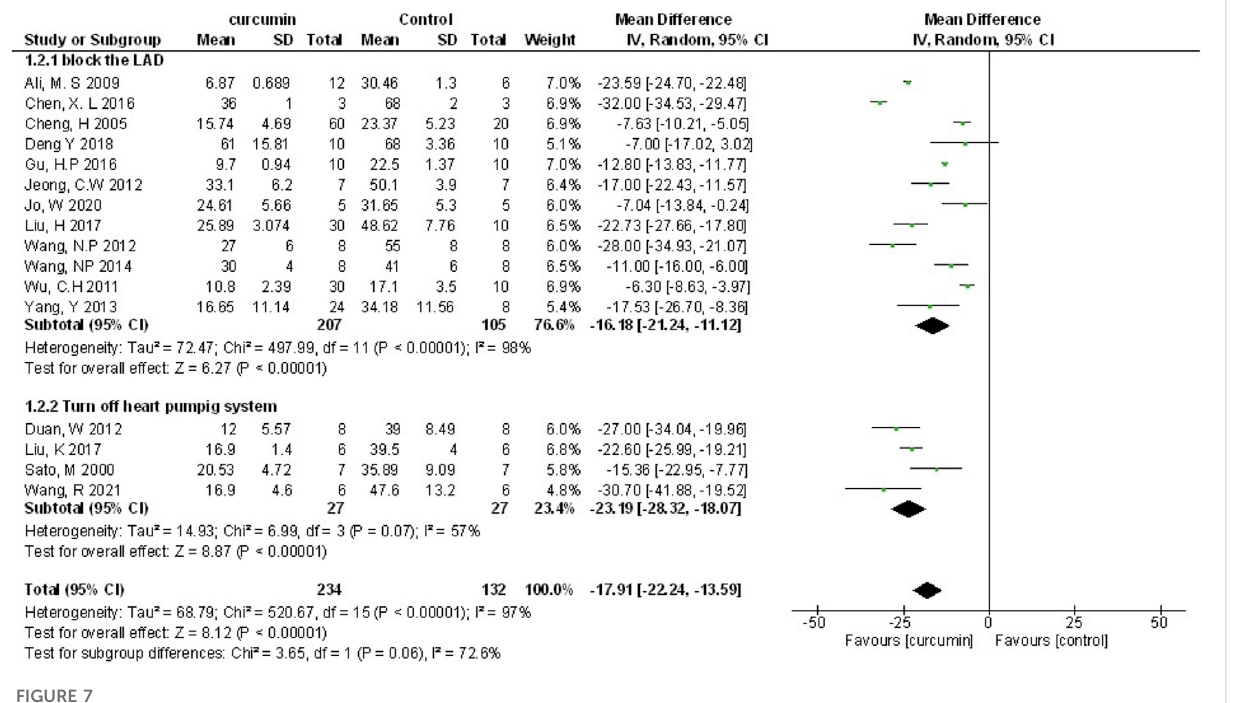
The subgroup analysis (method of model establishment) of curcumin on MI